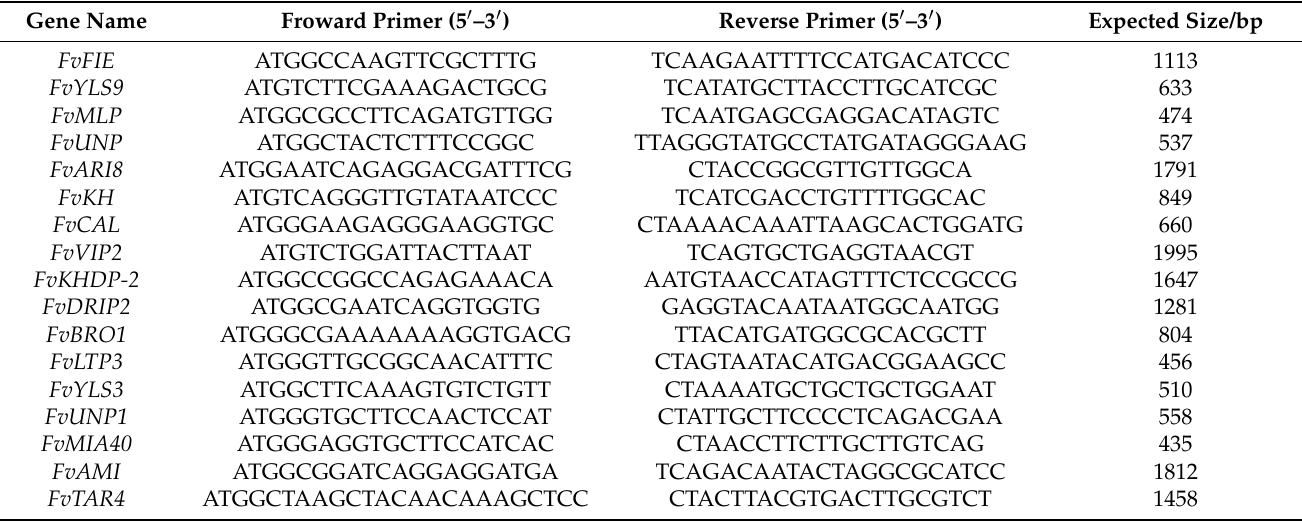
Table 3. Primer sequences for cloning candidate genes.